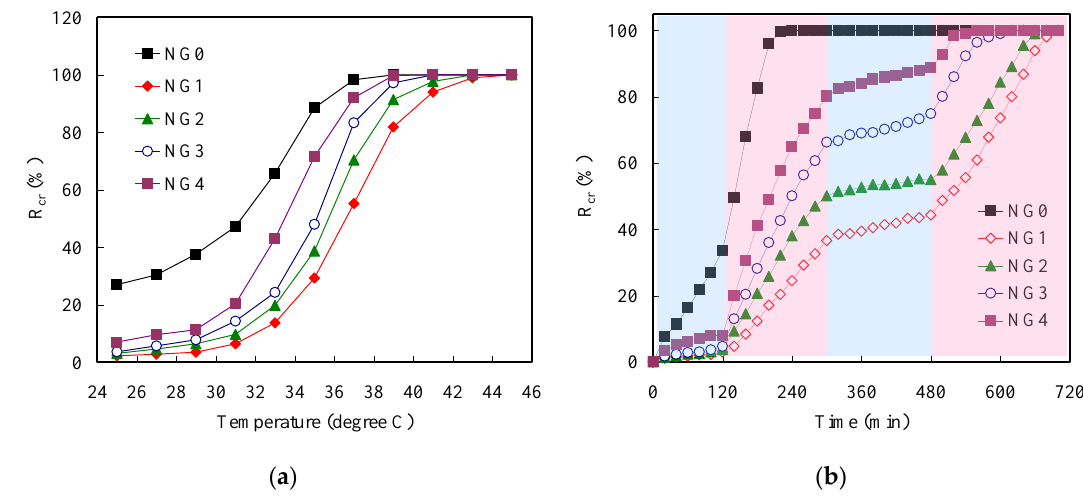
Figure 8. R cr of NG0, NG1, NG2, NG3, and NG4 ( a ) plotted with respect to temperature from 25 to 45 °C and ( b ) in real time over four stages: from 0 to 120 min at 25 °C, for the next 180 min in the bath of 45